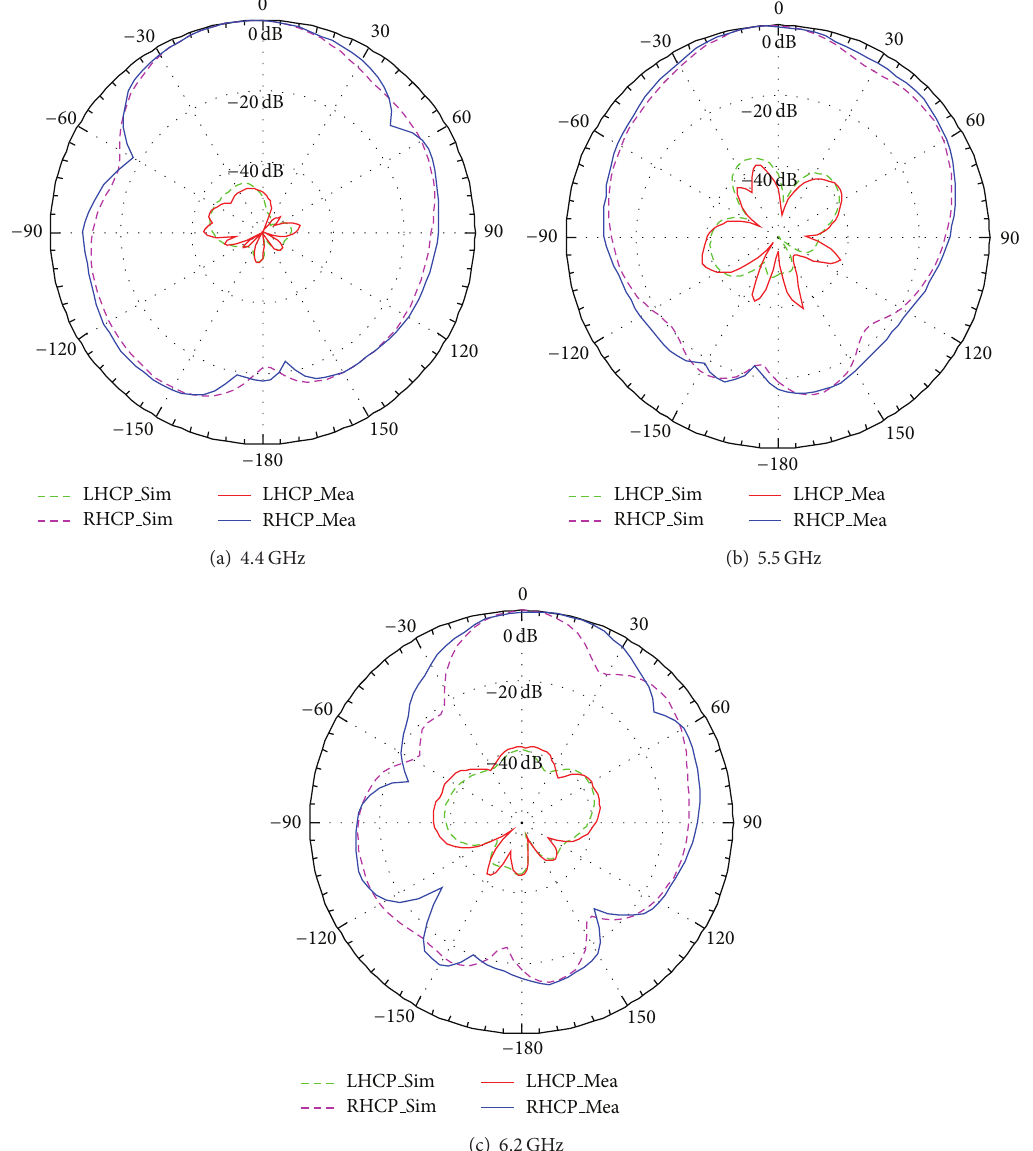
Figure 15: Simulated and measured radiation patterns of the antenna at 4.4 GHz, 5.5 GHz, and 6.2 GHz in the 𝑥𝑧